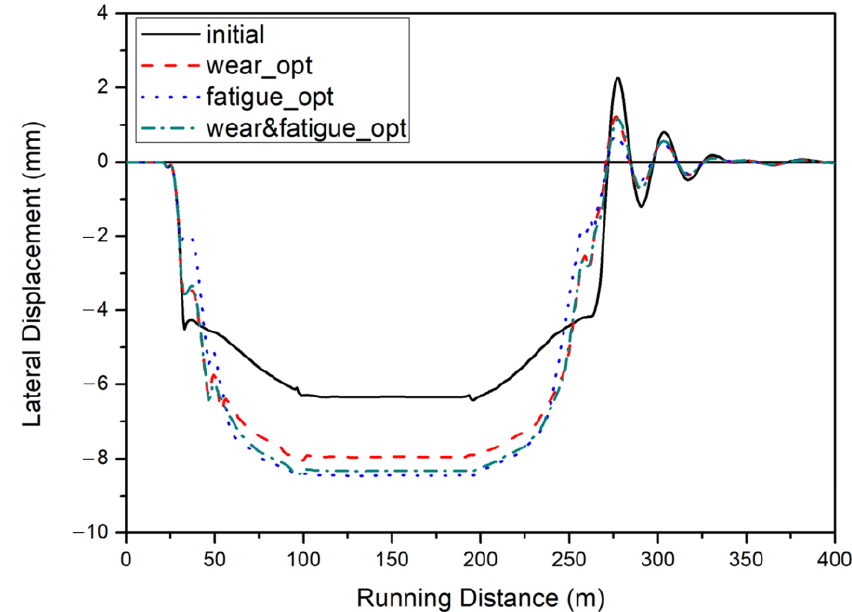
Figure 15. Derailment quotient of wheel.